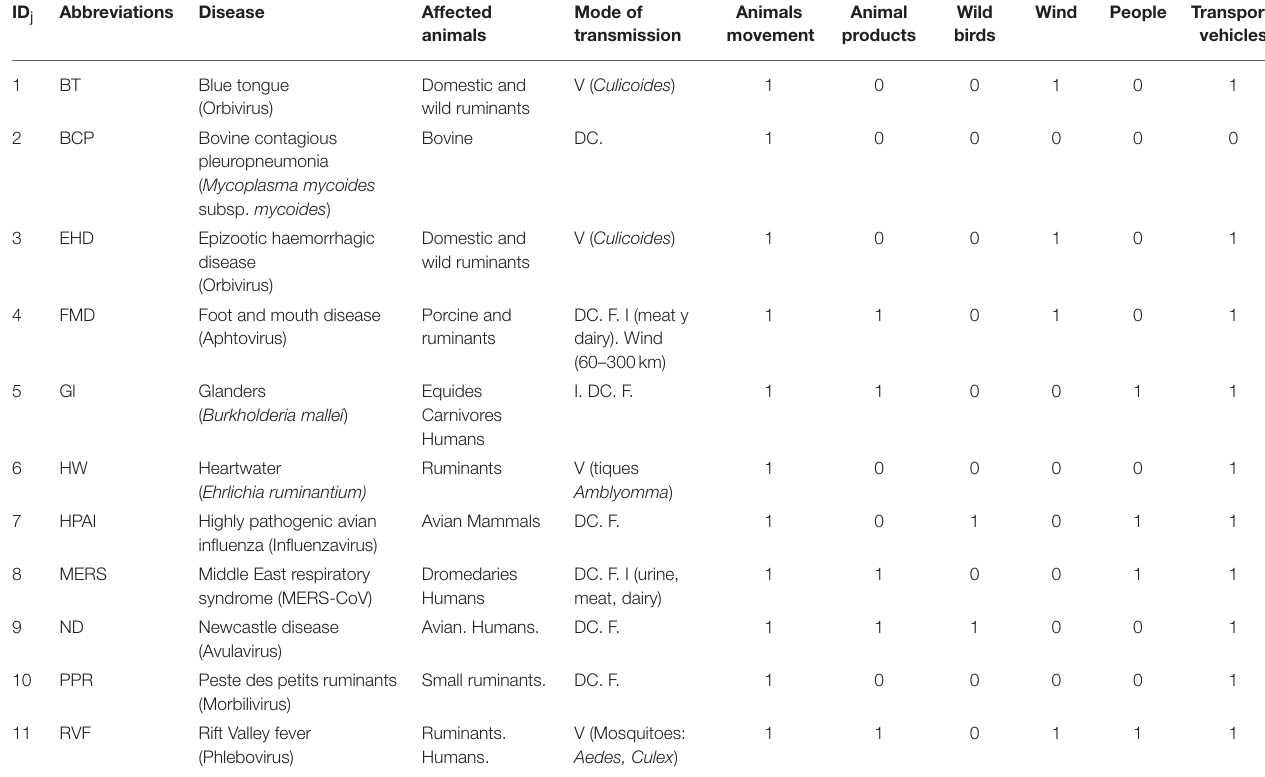
TABLE 2 | Infectious diseases selected for the analysis, their identificationin this study (ID j ), standard abbreviations, type of affected animals, mode of transmission (DC, direct contact; V, vector-born; F, fomites; I, food-borne) and routes of entry (0: no entry; 1: entry). ID j Abbreviations